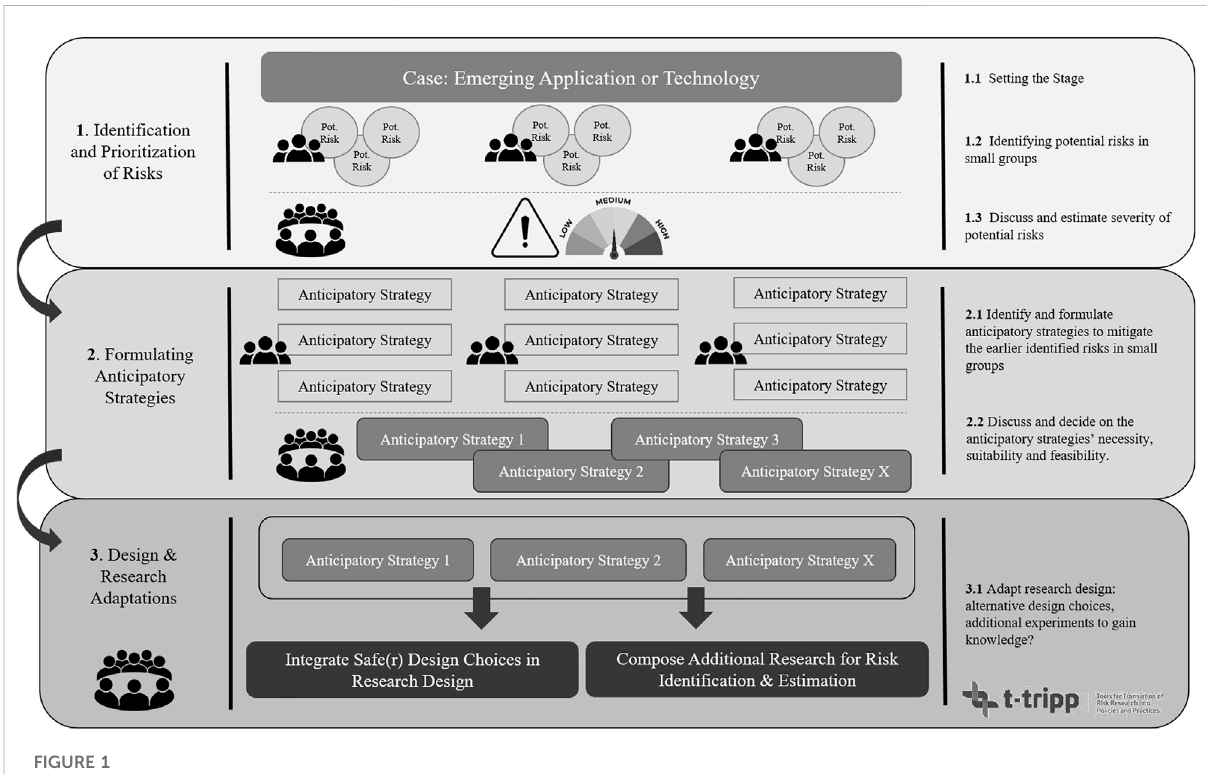
FIGURE 1 Flowchart for steps to follow during the social learning